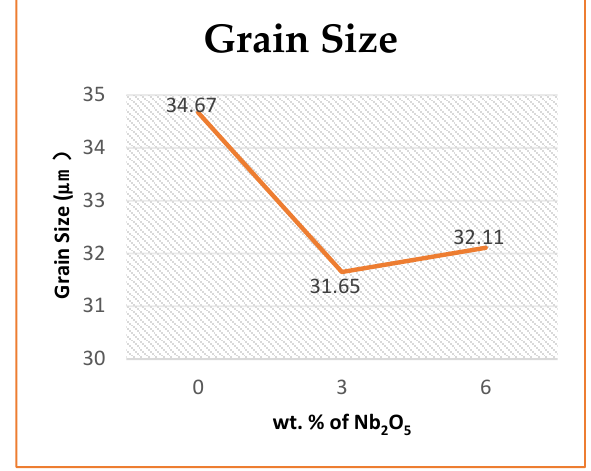
Figure 5. XRD shows the intensity of different phase compositions.